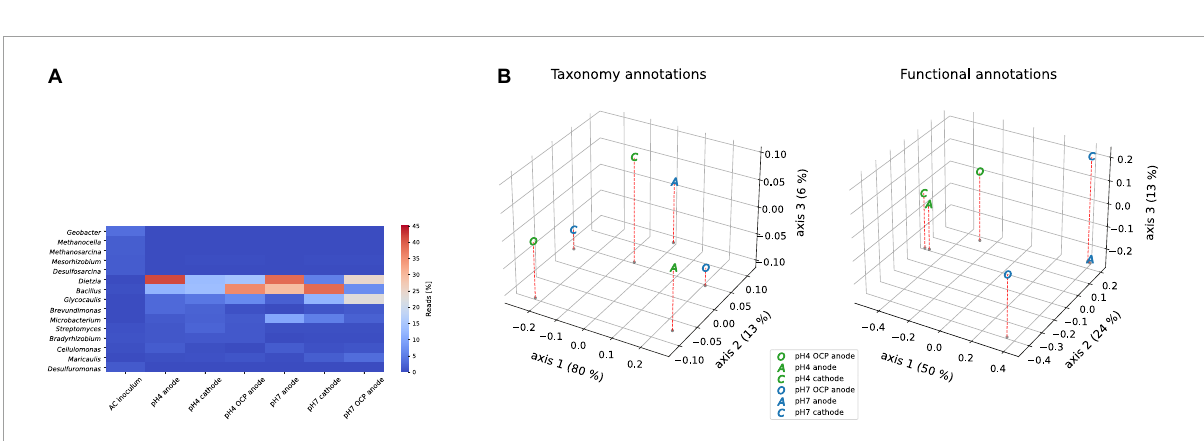
FIGURE3 (A) Taxonomy analysis of the top 15 genera across all metagenomes. (B) Principal coordinate analysis (PCoA) based on taxonomy (genus level) and functional features of the metagenomes using Bray-Curtis dissimilarity on a relative abundance matrix.